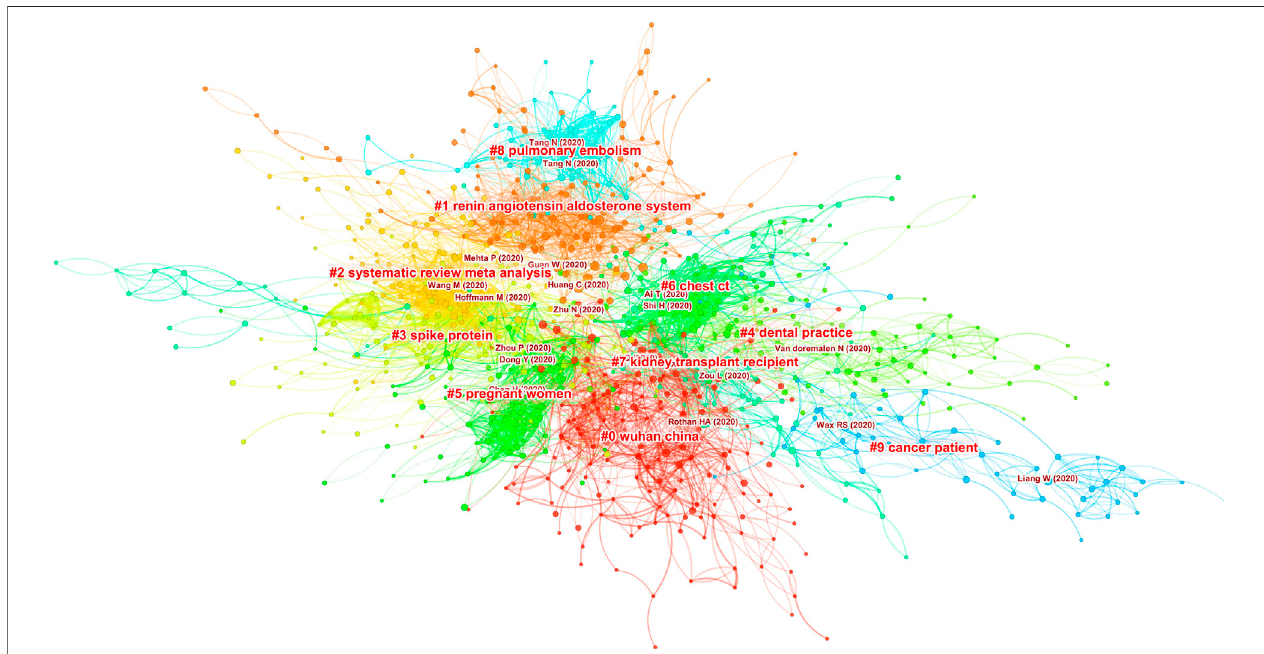
FIGURE 1 | An overview of 1,330 top-cited articles in the COVID-19 literature of 77,897 articles. The size of a node represents the number of times the corresponding article has been cited in the dataset. The prominent theme of each cluster of cited articles is algorithmically labeled.